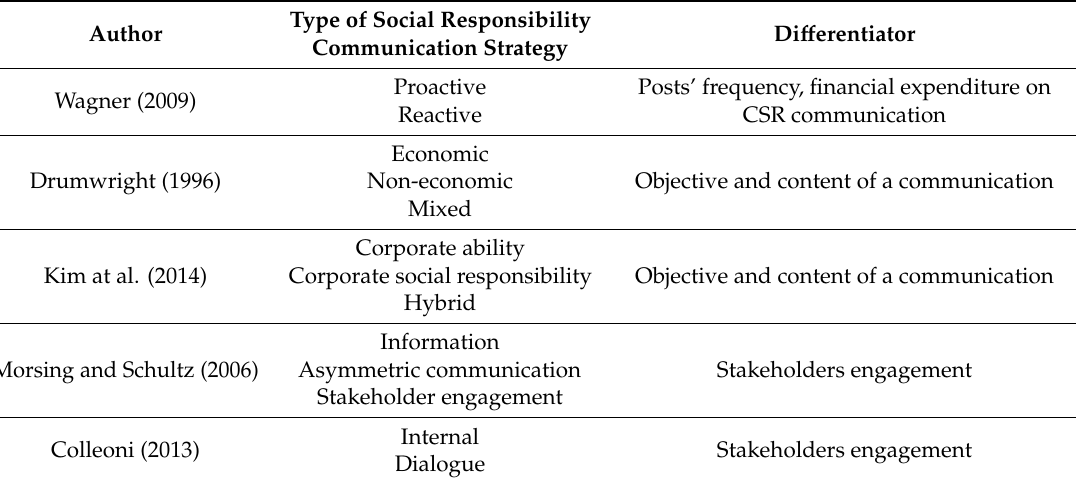
Table 2. Typologies of social responsibility communication